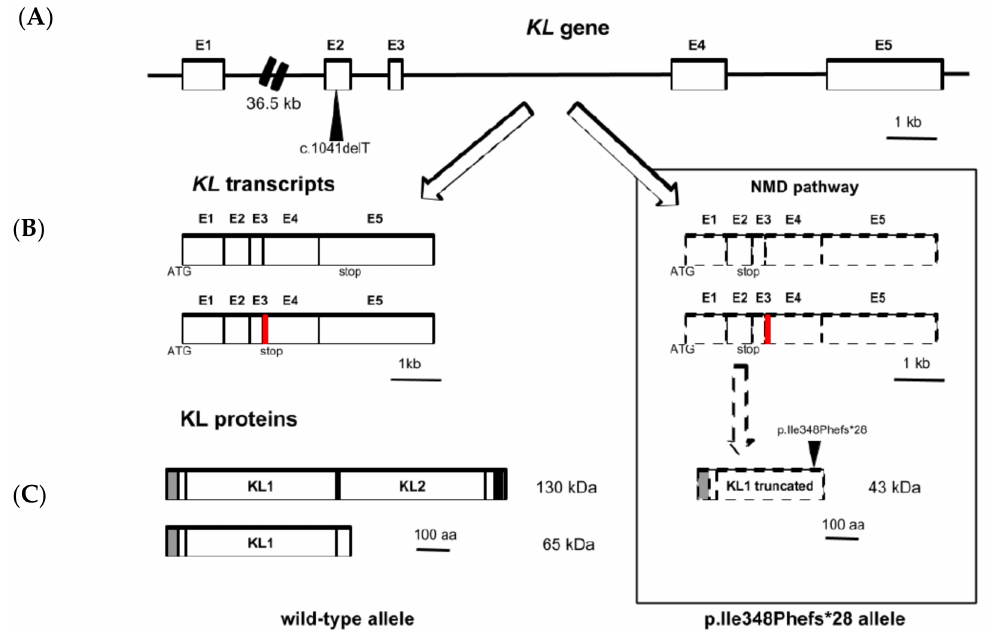
Figure 2. KL gene expression with the heterozygous p.Ile348Phefs*28 variant. ( A ) KL gene (50 Kb) is structured in five exons with c.1041delT allele located within exon 2. ( B ) KL processed transcripts carrying wild-type allele (left) can be found as complete mRNAs (coding for exons 1–5) or as shorter splicing variants (coding for exons 1-4, with an alternative sequence between exons 3–4 indicated in red). KL transcripts carrying c.1041delT allele (right) are degraded through an NMD pathway due to the introduction of a premature termination codon in exon 2 (dashed line). ( C ) The transcripts are translated into a full-length transmembrane KL protein (130 KDa) with two functional domains (KL1 and KL2) that can generate a soluble form from its shedding by membrane metalloproteases or into a shorter soluble form (only with KL1 domain), encoded by the alternative splicing transcript, which is directly secreted from the cell (65 KDa) (left). The putative KL protein with the p.Ile348Phefs*28 variant would be a shorter form (43 KDa) with a truncated KL1 domain